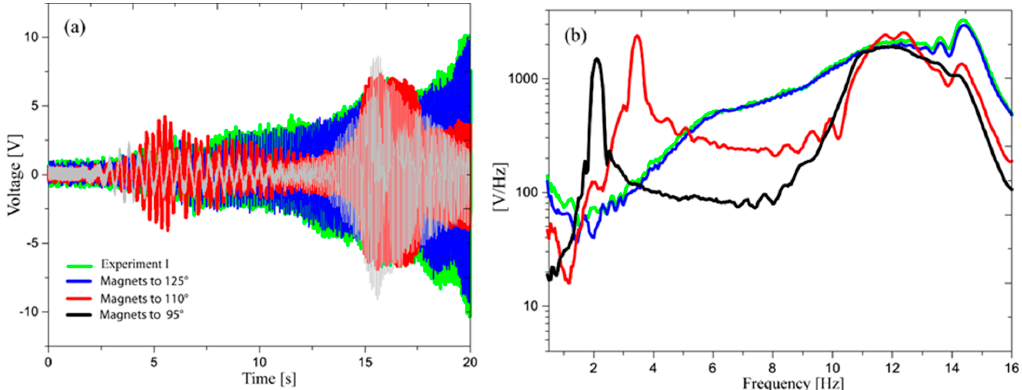
Figure 8. Experiment III (piezo-inductive mode) performed with corresponding selected tests to inductive mode I and magnets to 125°, 110°, and 95°. ( a ) Output voltage. ( b ) Frequency response function.